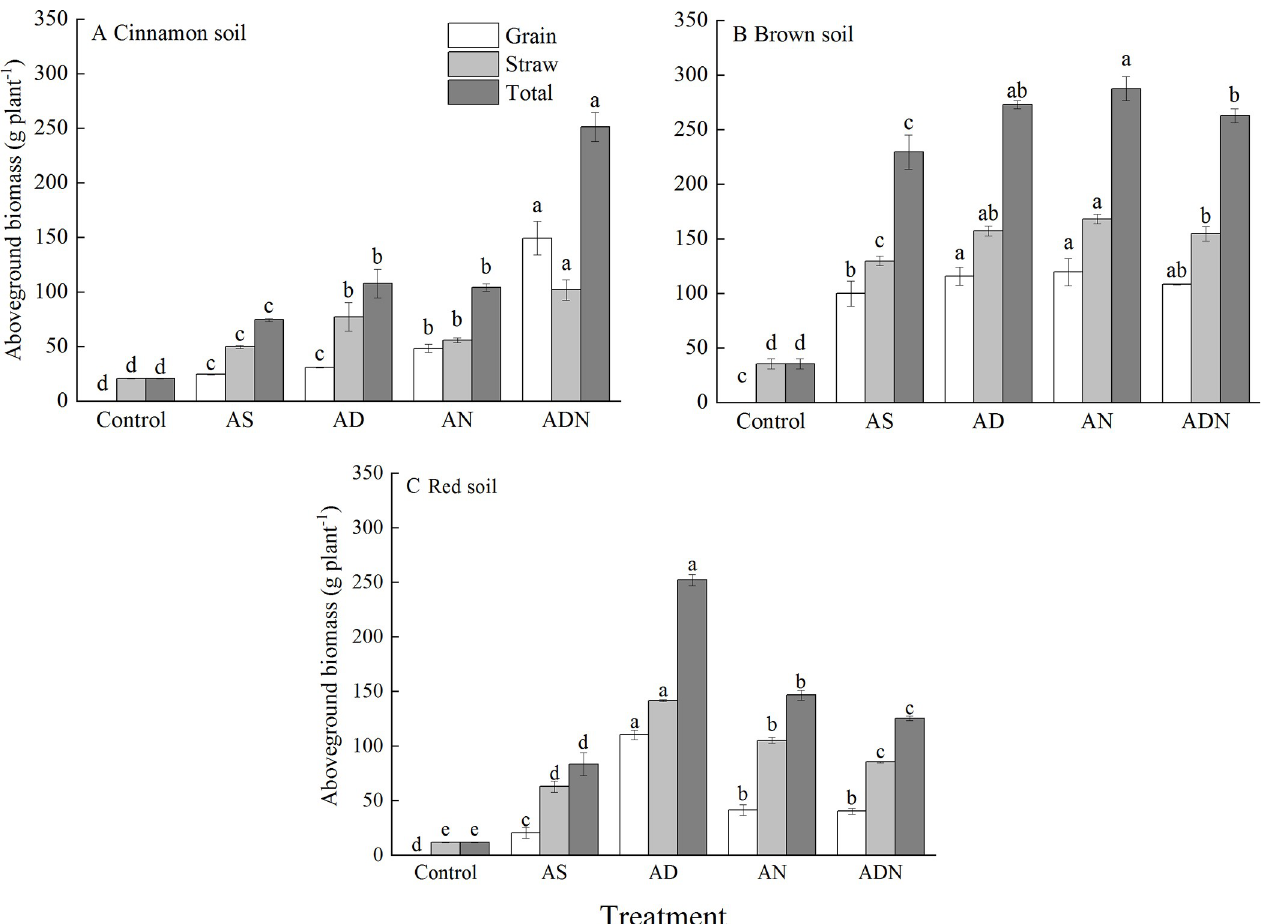
Fig 3. Aboveground biomass of maize under different treatments in three soils. Treatment: AS, ammonium sulphate; AD, AS+3, 4-dimethylpyrazole phosphate (DMPP); AN, AS+nitrogen protectant (N-GD); ADN, AS+3, 4-dimethylpyrazole phosphate (DMPP)+nitrogen protectant (N-GD). Error bars represented standard deviations ( n = 3). Different letters indicate significant differences between different treatments at P < 0.05 by Duncan